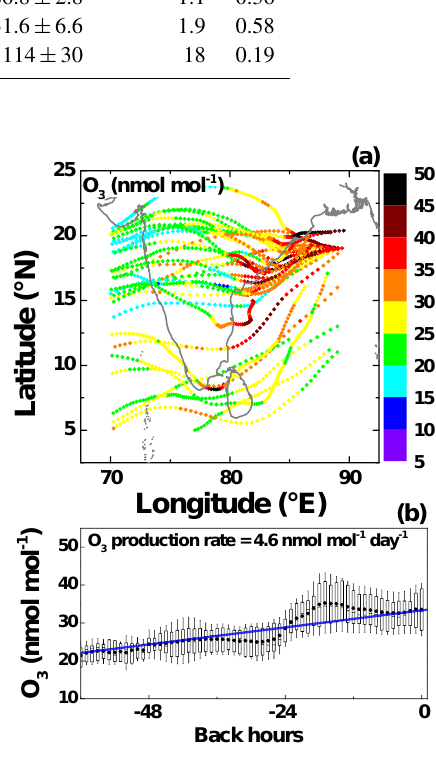
Figure 7. (a) WRF-Chem simulated O 3 along the air mass tra- jectories ending over a few representative locations over the BoB. (b) Variation of O 3 mixing ratios with time along the trajectories as shown in (a) . In box plot, the black dots and lines inside the box represent the mean and median of the data, respectively. While the lower and upper edges of boxes represent the 25th and 75th per- centiles, respectively, the whiskers represent standard